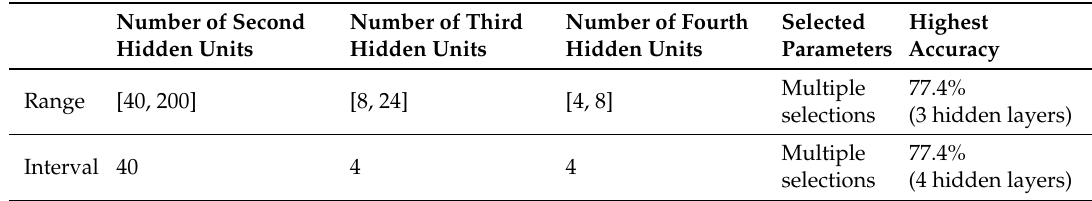
Table 9. Different parameters for